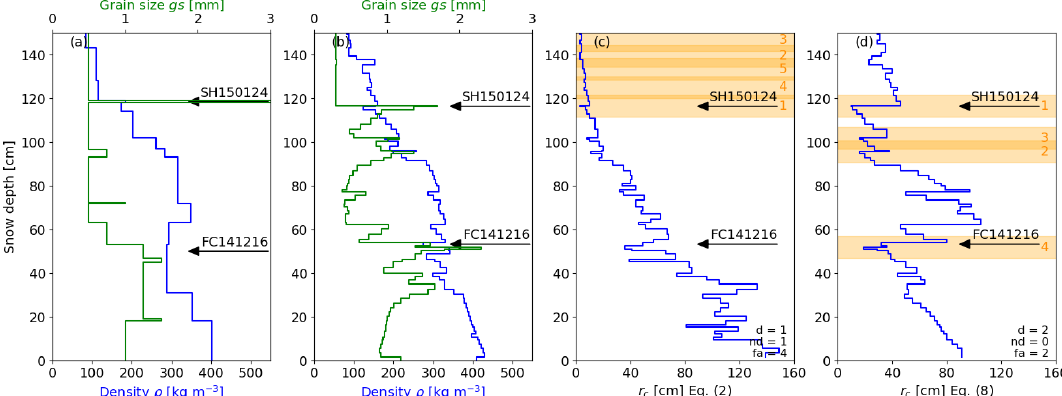
Figure 9. Observed (a) and simulated (b) density ( ρ ) and grain size (gs) profiles on 28 January 2015 at WAN7. Corresponding vertical r c profiles using layer properties from SNOWPACK for (c) the parameterization of Gaume et al. (2017) (Eq. 2) and (d) the optimized parameterization (Eq. 8). Arrows show the weak layers on which PST experiments were performed. Orange bars show the lowest values in the vertical r c